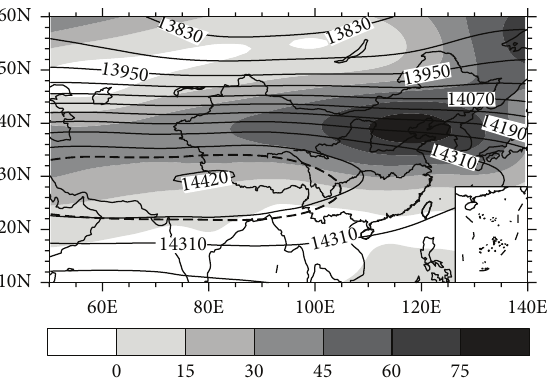
Figure 5: The distribution of geopotential height (solid line) and the anomaly (shaded area) at 150hPa in the summer of 2013 (gpm). The dashed line (14360 gpm) indicates the climatological position of SAH.